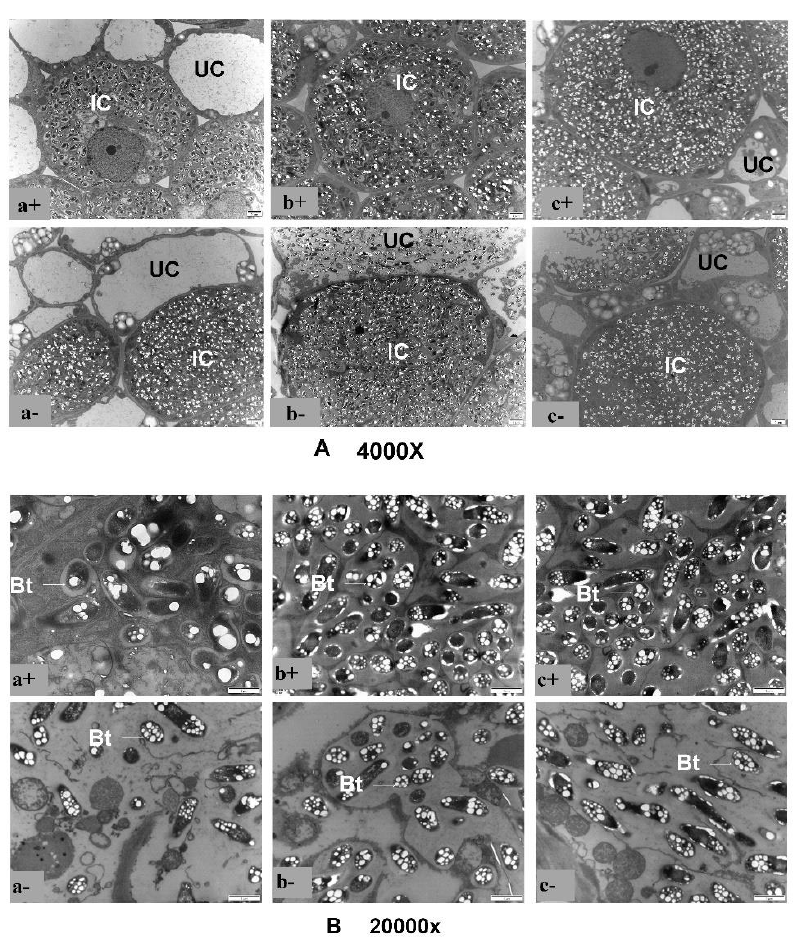
Figure 2. Ultrastructure of nodules on both sides of a dual-root soybean plant at V4 stage: ( A ) is under a transmission electron microscope 4000×, ( B ) is under a transmission electron microscope 20000×; a+: P1/0 P+; a-: P1/0 P – ; b+: P31/0 P+; b-: P31/0 P – ; c+: P61/0 P+; c-: P61/0 P – ; IC: infected cell; UC: uninfected cell; Bt: